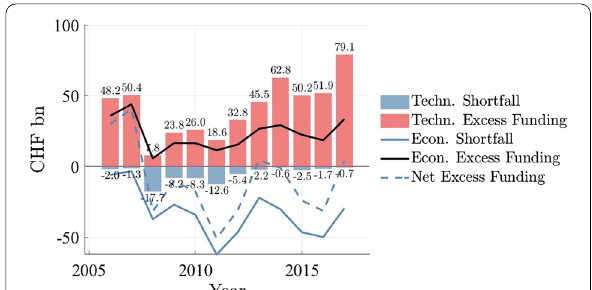
Fig. 6 Aggregated Gross Excess Funding and Shortfall.Aggregated gross and net excess funding and shortfall, based on technical pension liabilities (Technical) and pension liabilities determined at market rates (Econonomic). Economic funding shortfall and